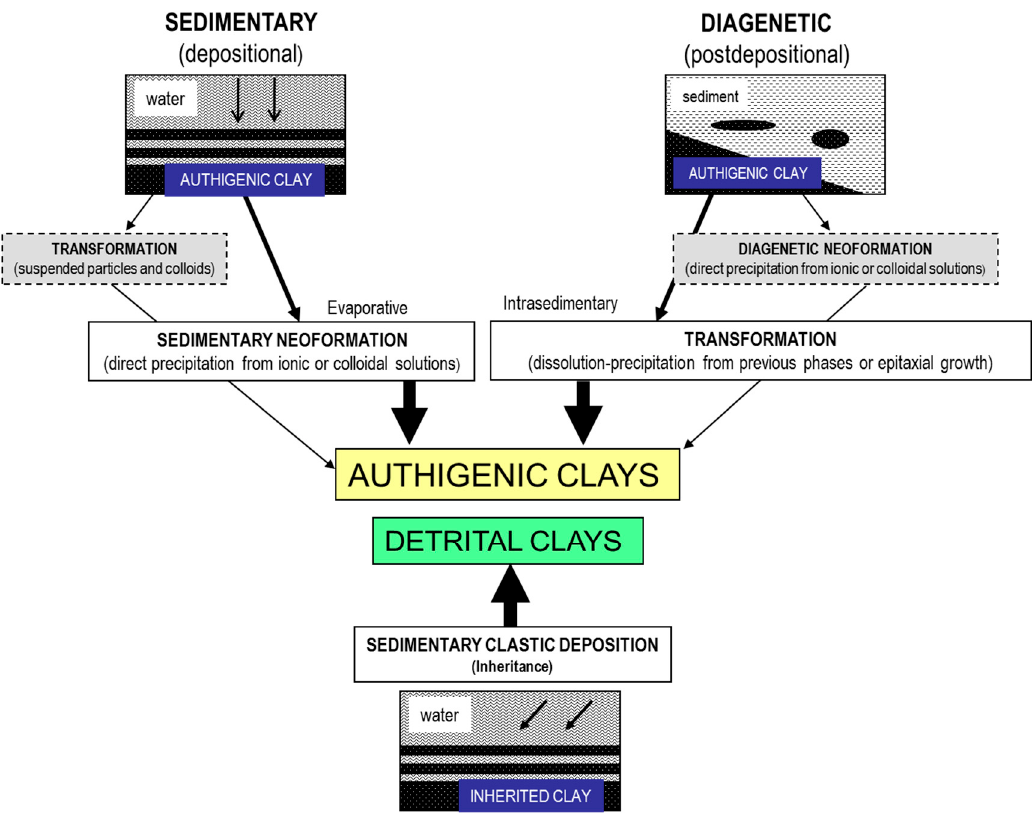
Figure 1. Diagrammatic sketch showing the relationships between detrital and authigenic clays with emphasis in their models of formation.